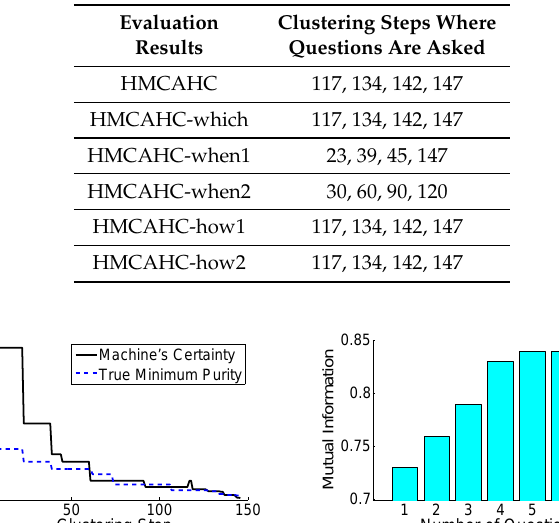
Table 2. Questions asked in the Iris Flower Data Set.